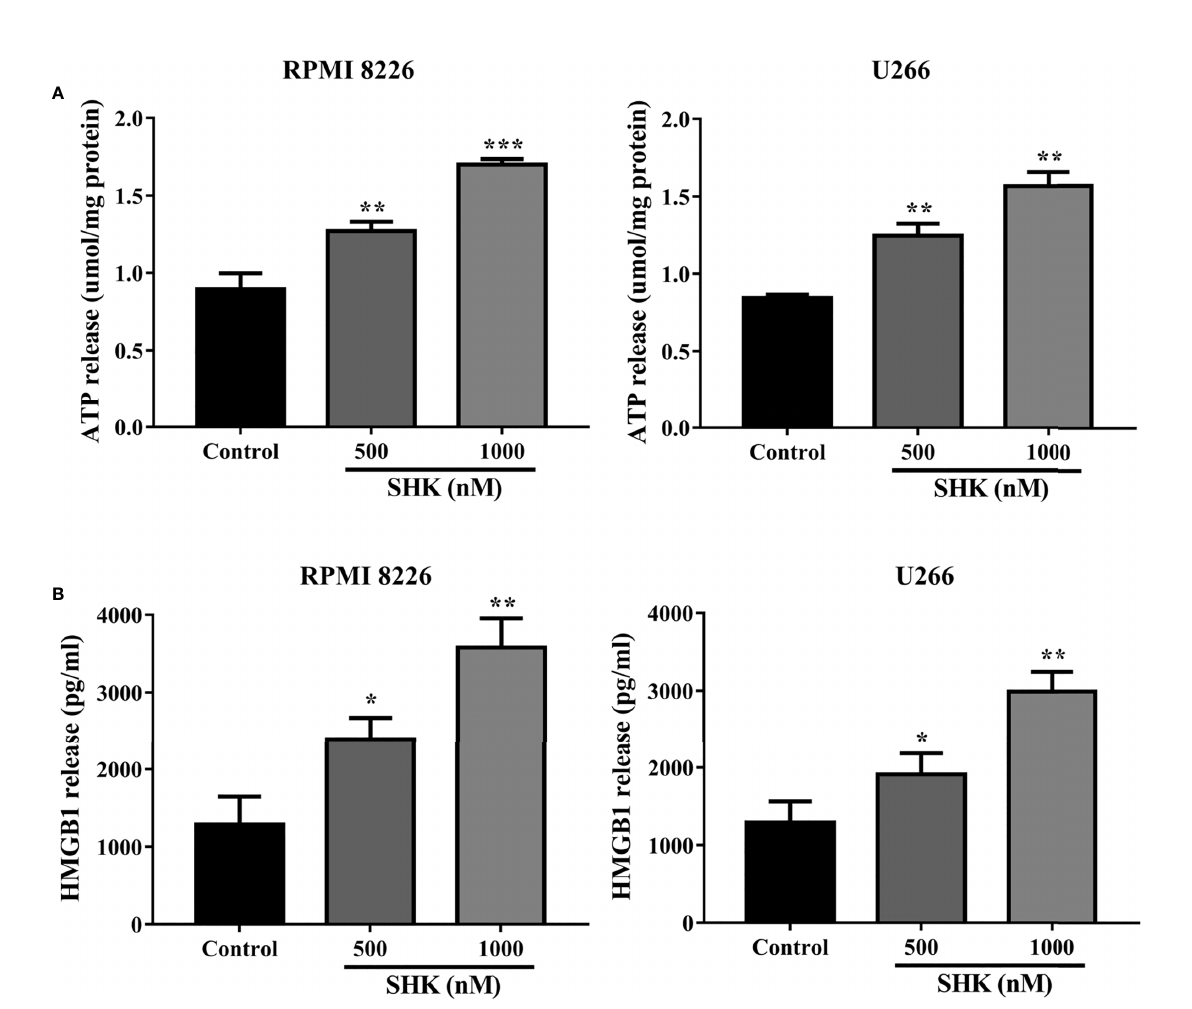
FIGURE 3 SHK Treatment triggers immunogenic ferroptosis of MM cells. (A) Extracellular ATP release in MM cells following different concentrations of SHK. (B) Extracellular HMGB1 release in MM cells following different concentrations of SHK. Data are presented as the mean ± SD. * p < 0.05, ** p < 0.01, *** p <